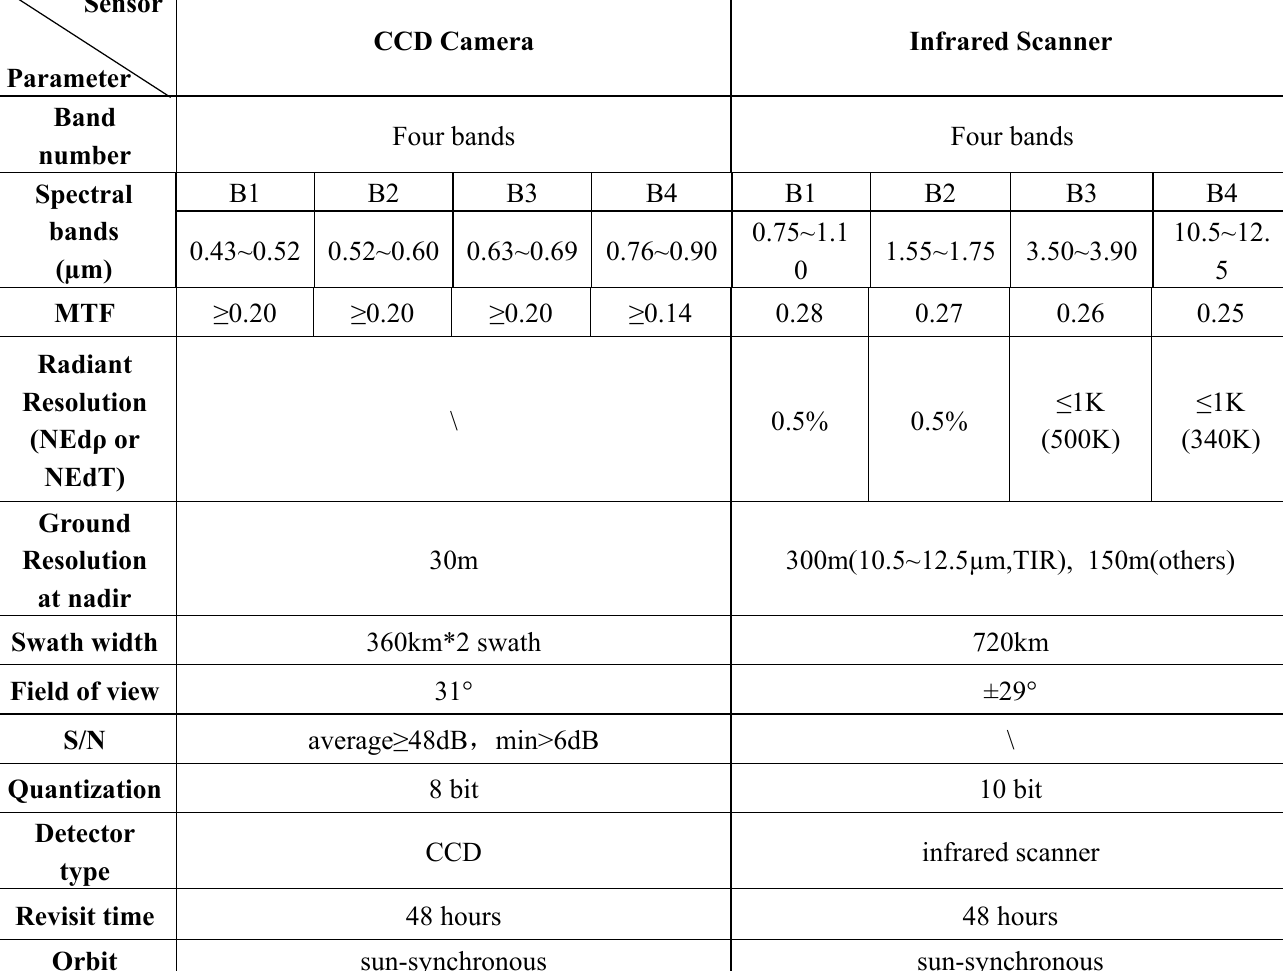
Table 1. Specifications of the HJ-1B main